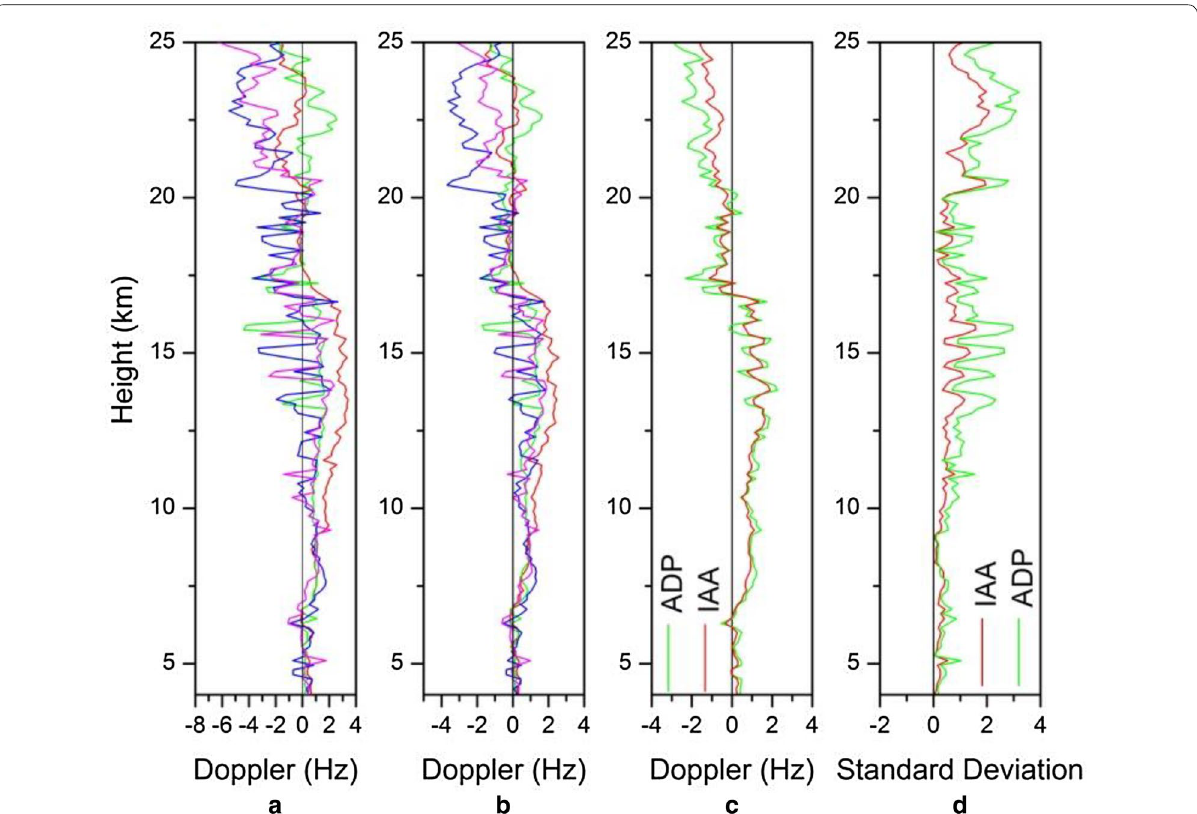
Fig. 5 Doppler height profiles for four scans of the east beam using a ADP, b IAA. c Mean Doppler height profile of the east beam. d Standard deviation for the east beam for February 9, 2015